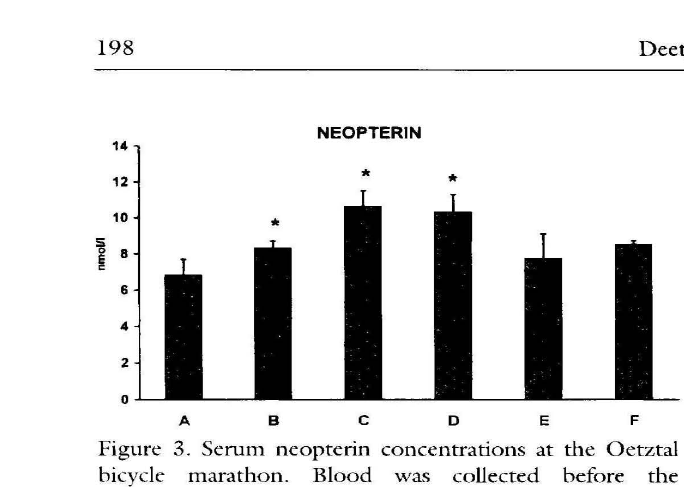
Figure 3. Serum neopterin concentrations at the Oetztal bicycle marathon. Blood was collected before the OEBM (=A), immediately after finishing the race (=B), as well as after one (=C), two (=D), three (=E) and five (=F) days post race. Values shown are median values in cluding the 25th and 75th percentiles, respectively. *in dicates p<O.05.